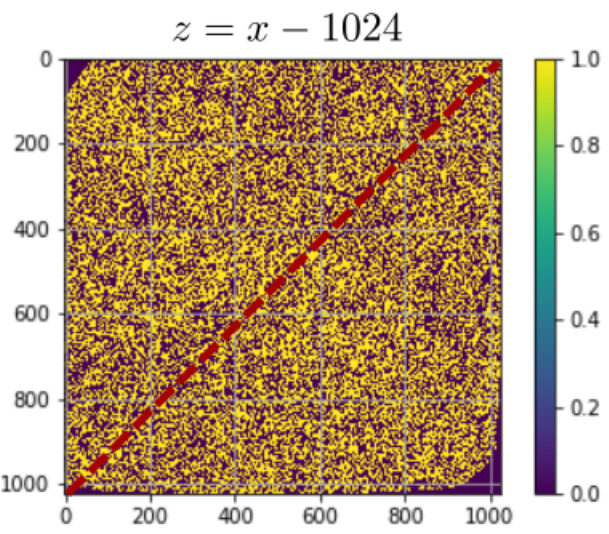
Figure 5. The result of applying thresholding to τ ( x , z ) at the mean object field height is the membership function τ χ ( x , z ) . The raster integration line z = x − 1024 shown in dashed red is the basis for the analysis of Figure 6.